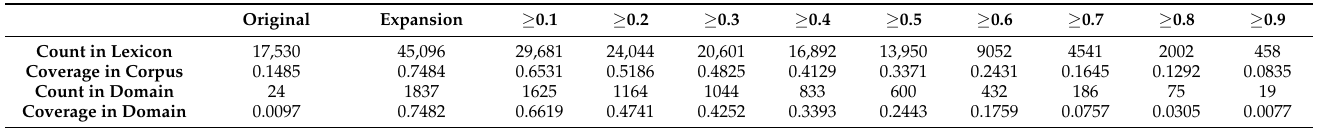
Table 1. Coverage Comparison in Different Lexicons and Valences.